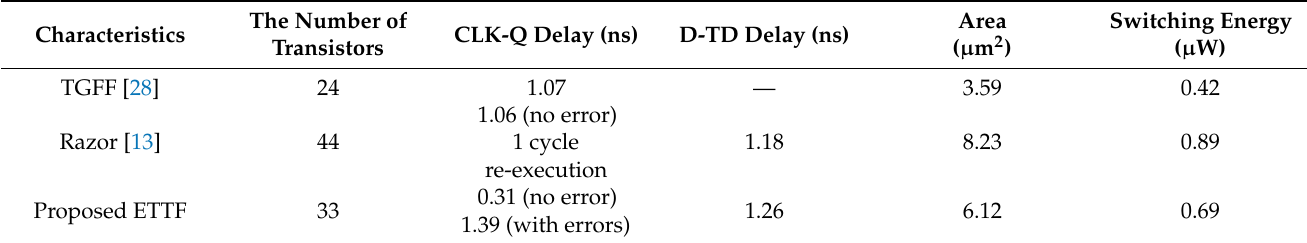
Table 2. Characteristics of the proposed ETFF compared to the Razor [13] and TGFF [28] at 0.6 V under TT process corner @ 25 ◦ C.